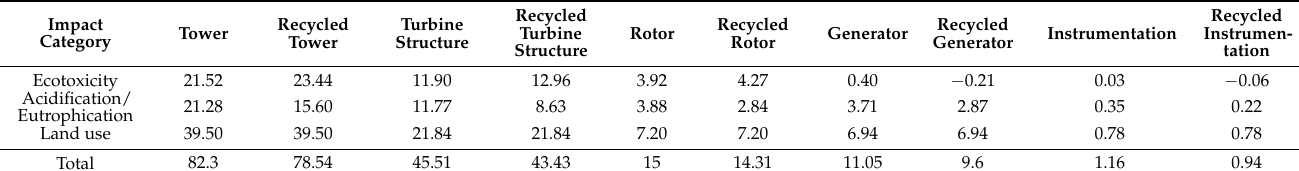
Table 5. Results of grouping and weighting—ecosystem quality (unit: Pt/1 p).